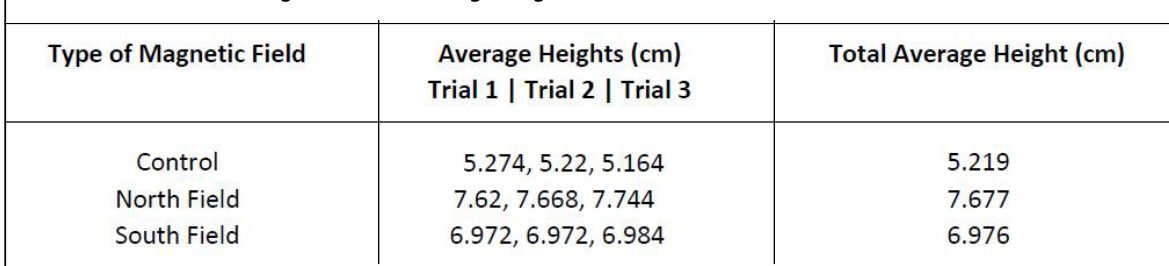
Table 1: Control and magnetic fields average heights in all three trials